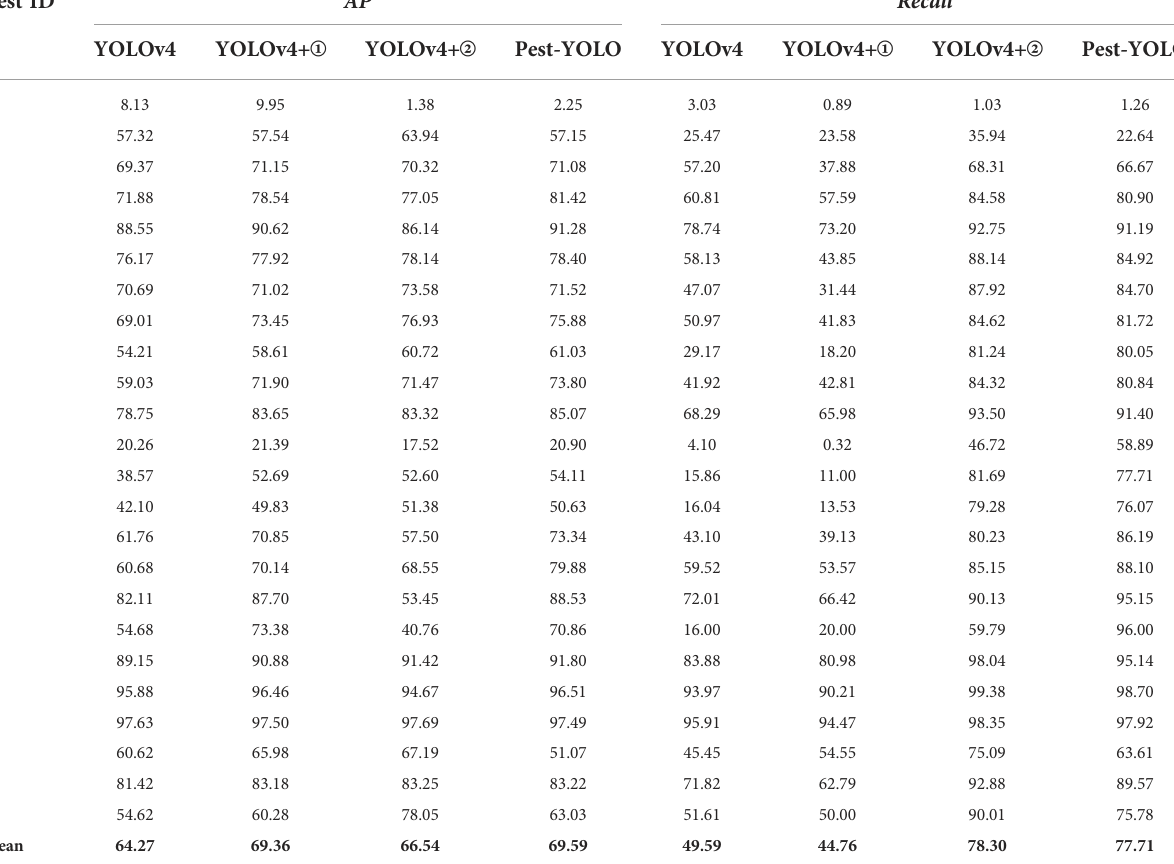
TABLE 5 AP and Recall for each type of pest in ablation experiments.